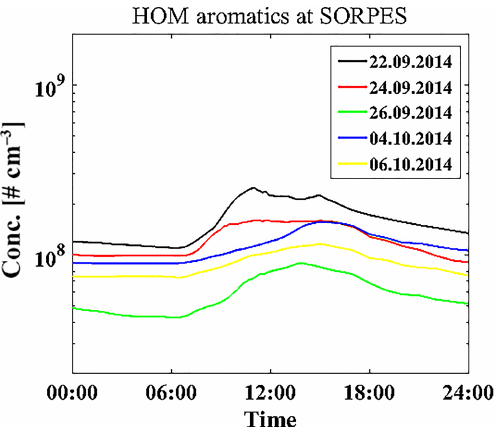
Figure 3. Simulated diurnal cycles of HOMs formed from aromat- ics oxidation at SORPES on each chosen day.